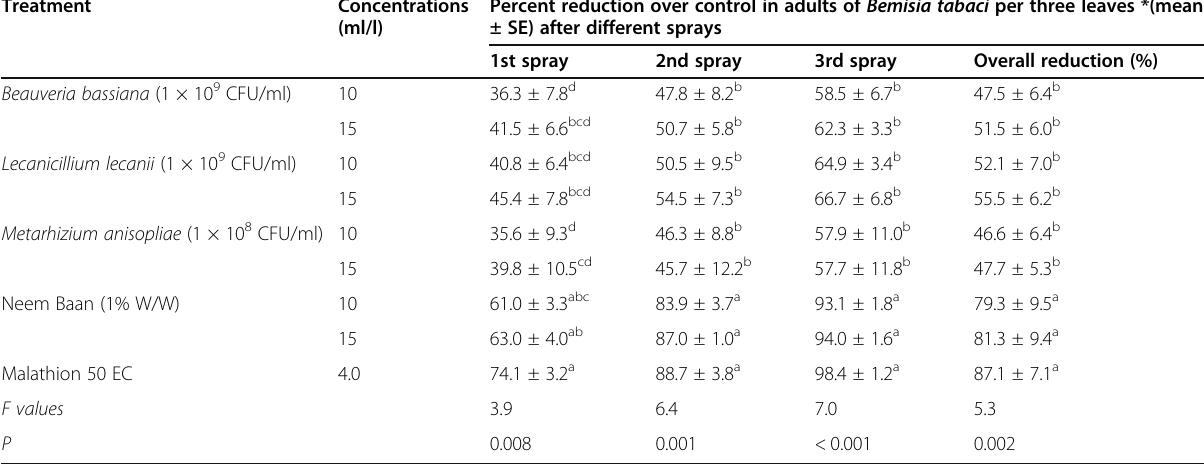
Table 6 Efficacy of different biopesticides against adults of Bemisia tabaci on cucumber under net house conditions during autumn cropping season (2017)